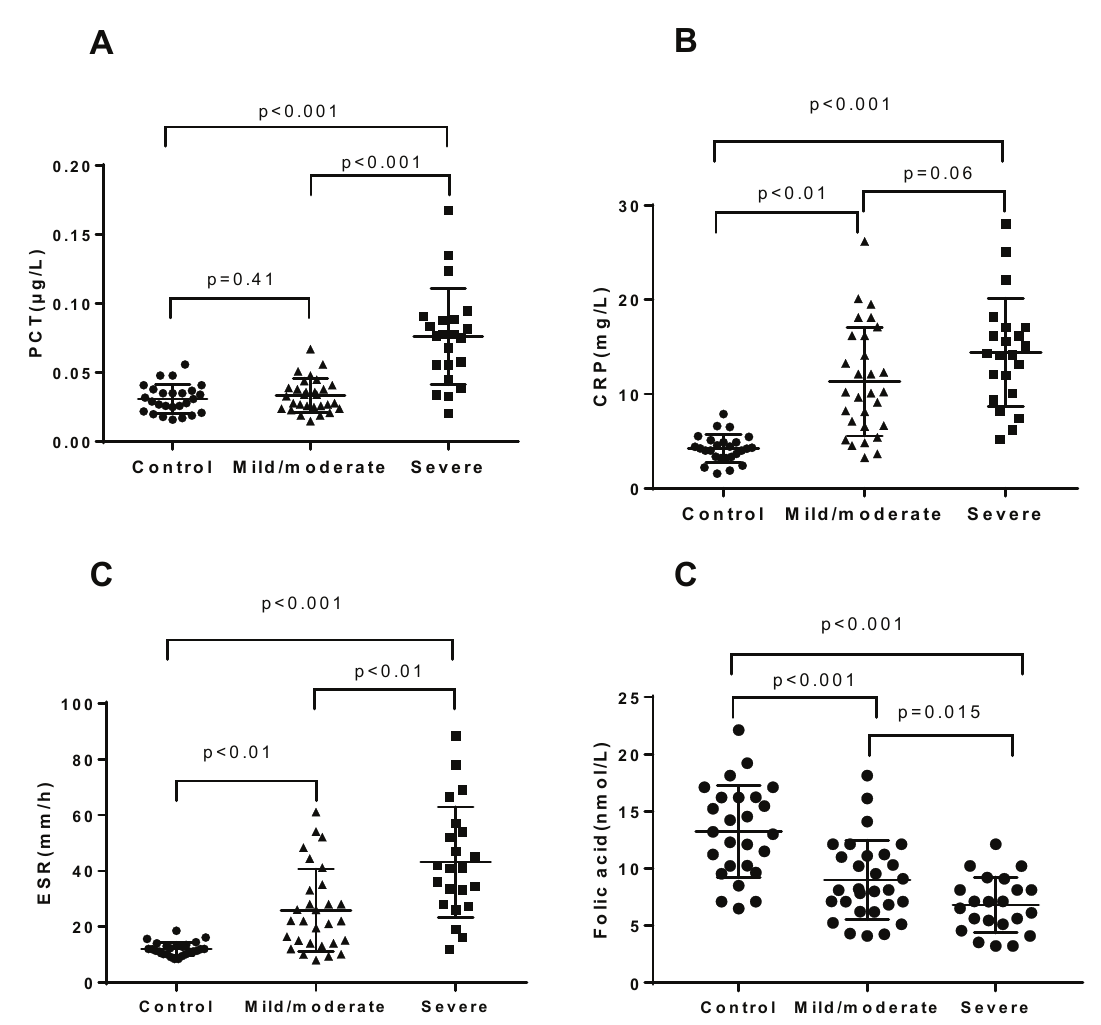
Figure 2: Serum PCT, CRP and ESR distribution among control, mild/moderate and severe UC groups (A: serum PCT comparison; B: serum CRP comparison; C: serum ESR comparison; D: serum folic acid